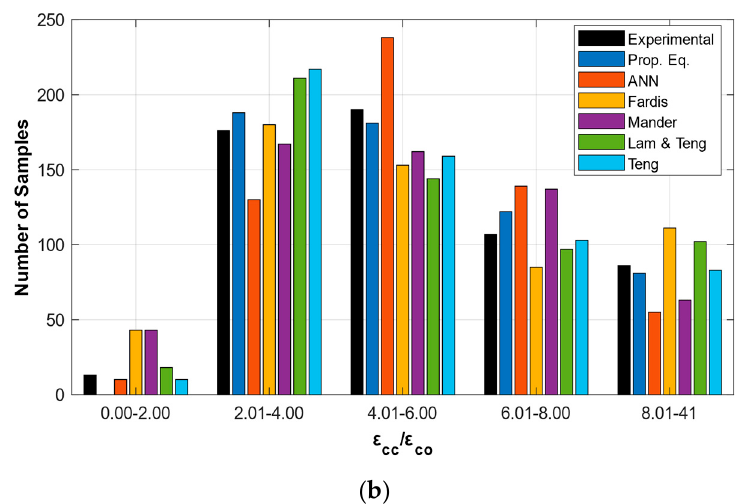
Figure 12. Distribution of values for FRP-wrapped cylinders: ( a ) strength ( f cc /f ′ co ); ( b ) strain ( ε cc / ε co ).